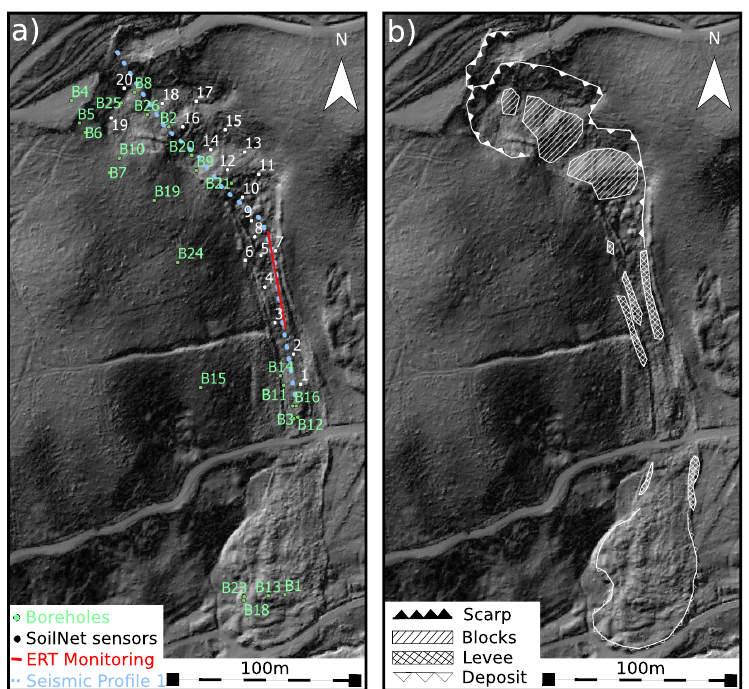
Figure 2. ( a ) Digital elevation model of the study area provided by the Geobasisdatendienst NRW with geoelectric monitoring profile line, seismic profile line, borehole locations and water content sensors, ( b ) as well as a simplified geomorphological